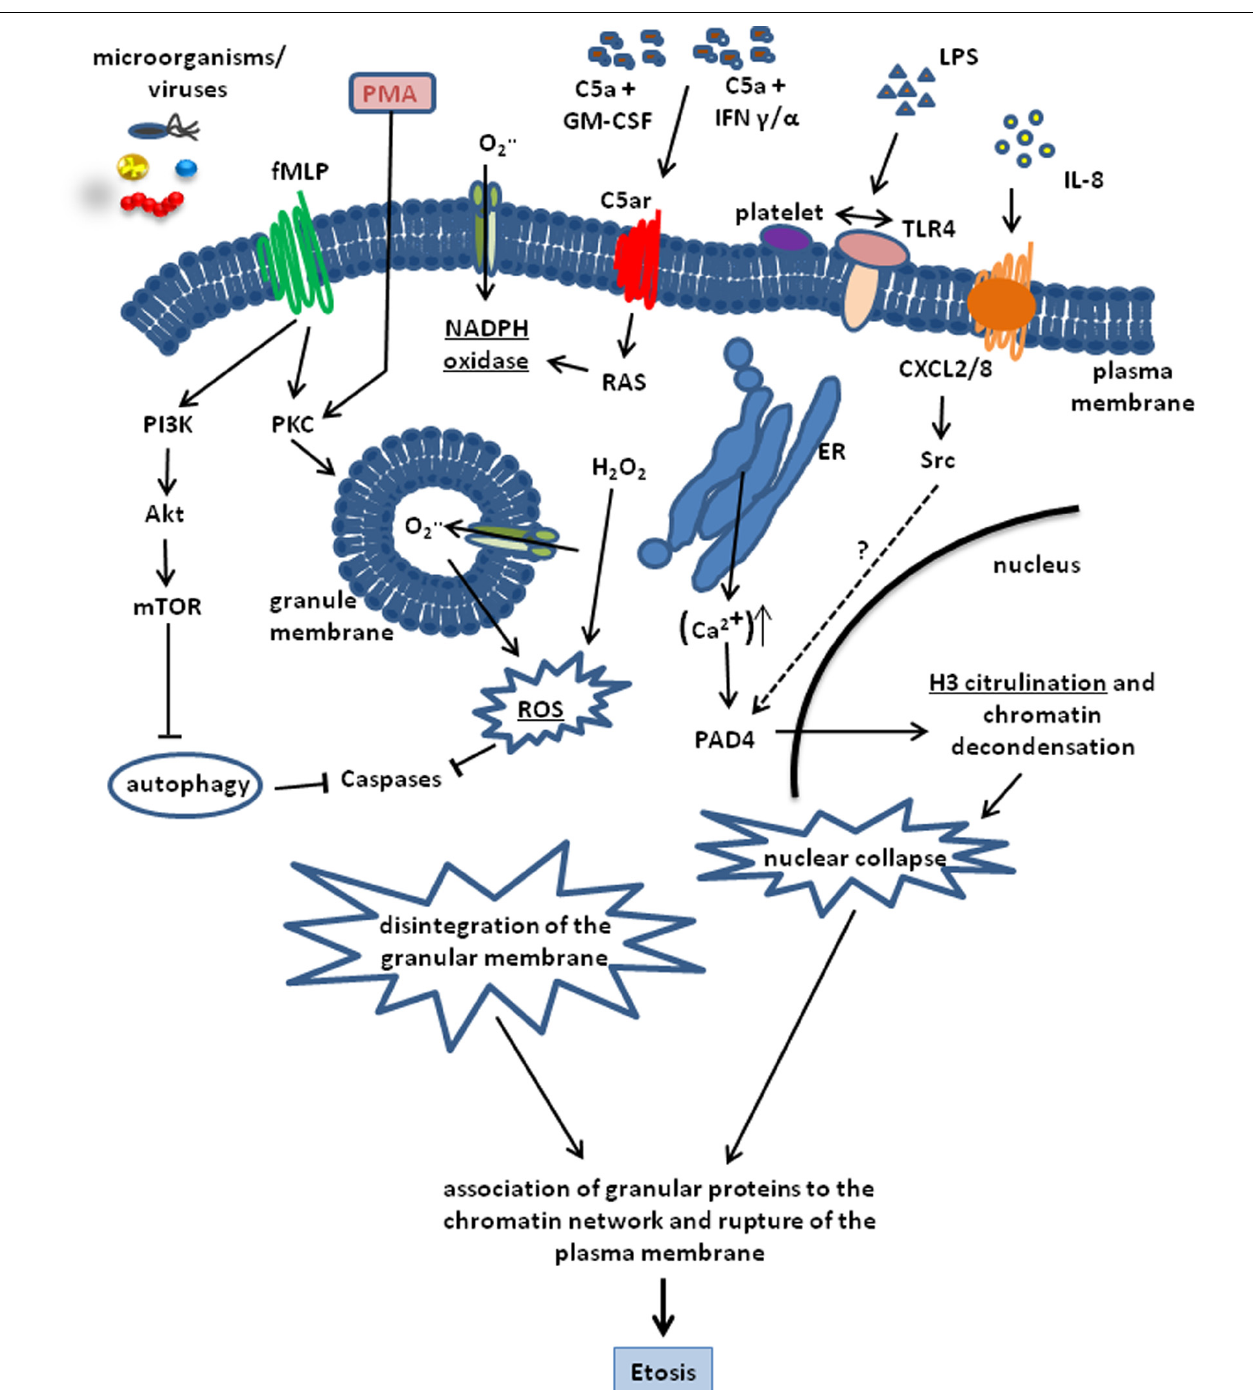
NADPH oxidase activity. On the other hand, fMLP blocks autophagy via PI3K, Akt and mTOR activation, which is able to prevent Etosis. NADPH oxidase activity results in ROS production and H3 citrullination leading to chromatin decondensation and nuclear collapse. Disintegration of the nuclear membrane and adsorption of antimicrobial granular proteins onto the decondensed chromatin network is the final step of Etosis that precedes the release of ETs into the surrounding milieu after rupture of the plasma